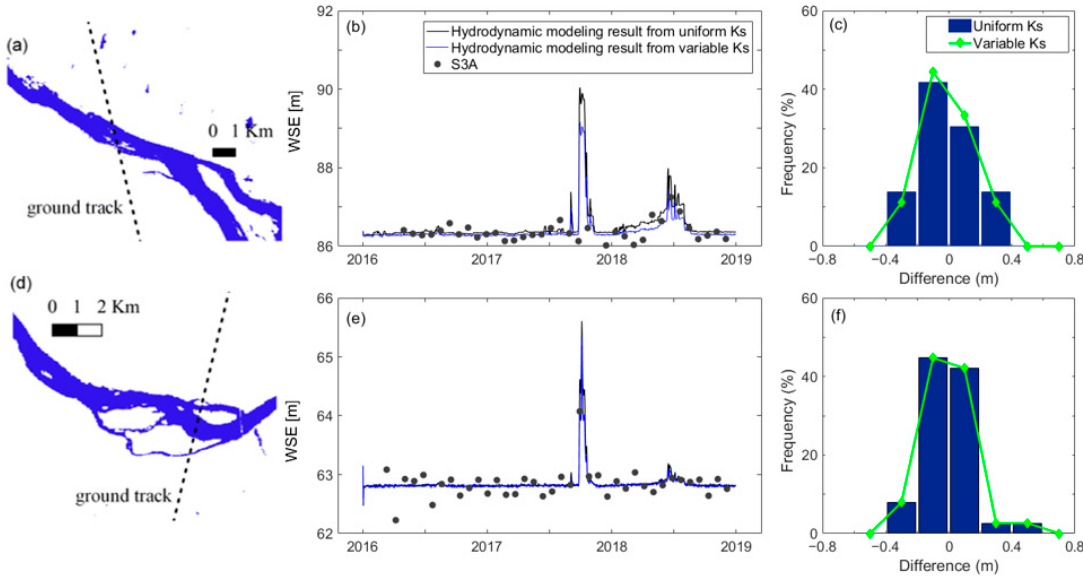
Figure 6. Validation of WSE obtained by configuration B against two virtual stations from Sentinel-3A. ( a , d ) Location of the two virtual stations. ( b , e ) Comparisons of simulated and satellite observed WSE during the calibration and validation periods. ( c , f ) The distribution of differences between simulated and satellite observed WSE from 2016–2018.